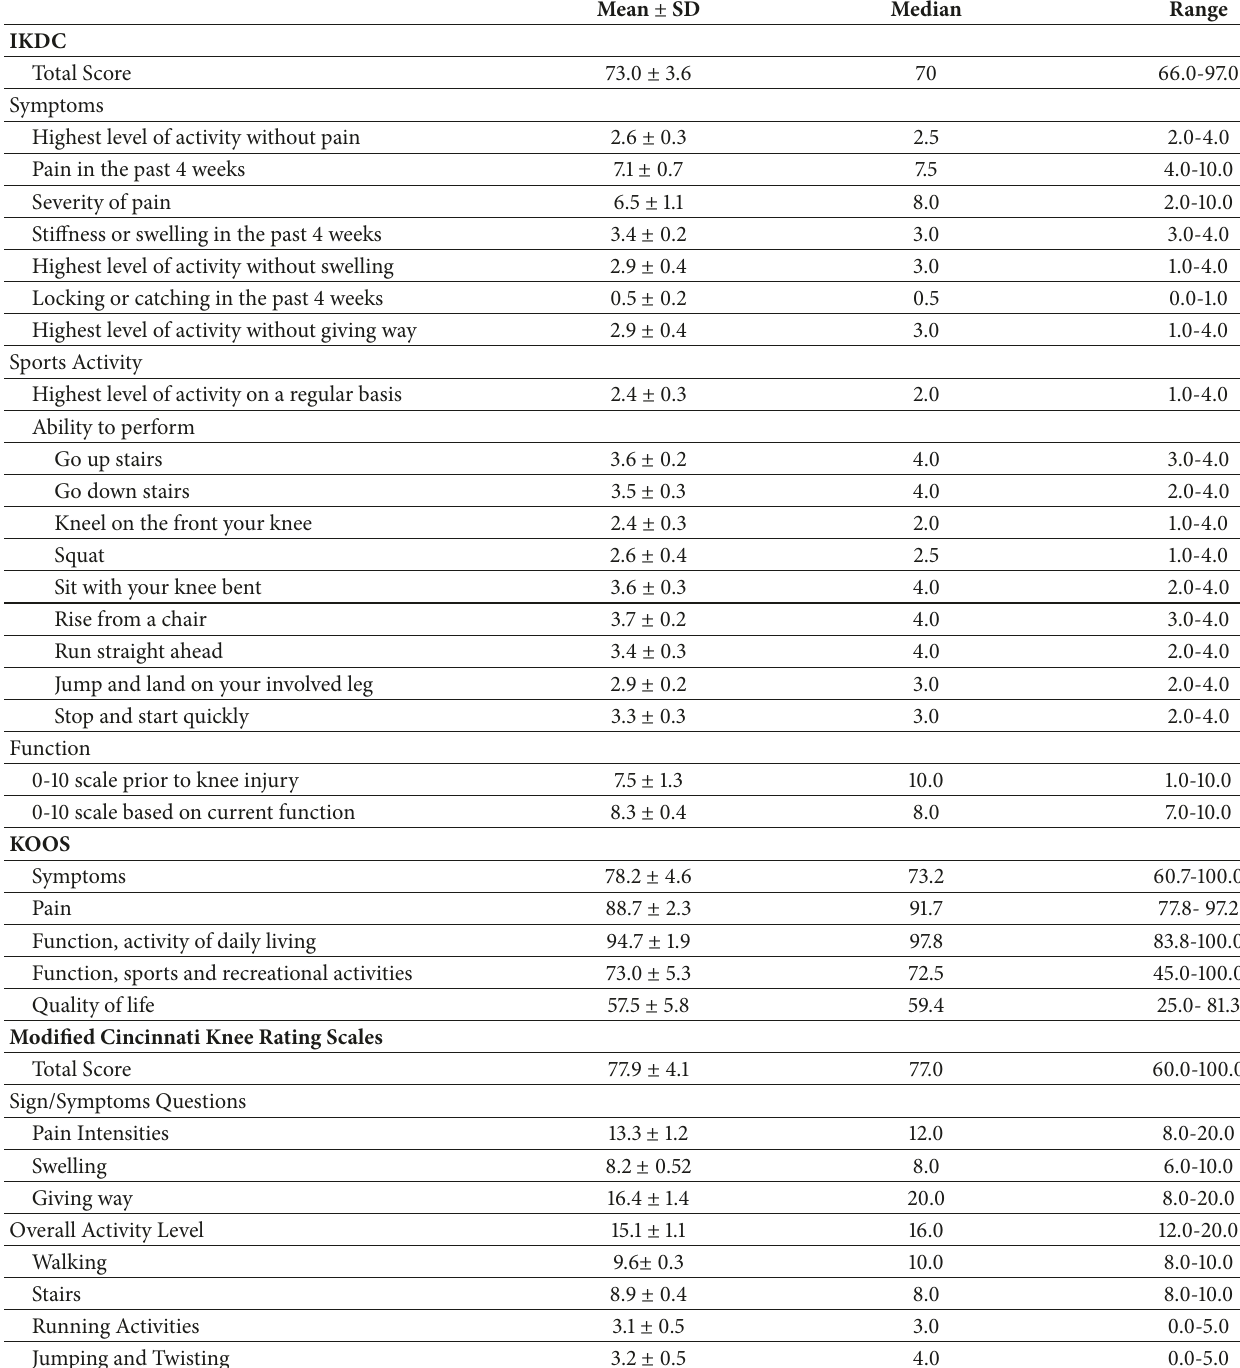
Table 2: Outcome of IKDC, KOOS, and Modified Cincinnati Knee Rating